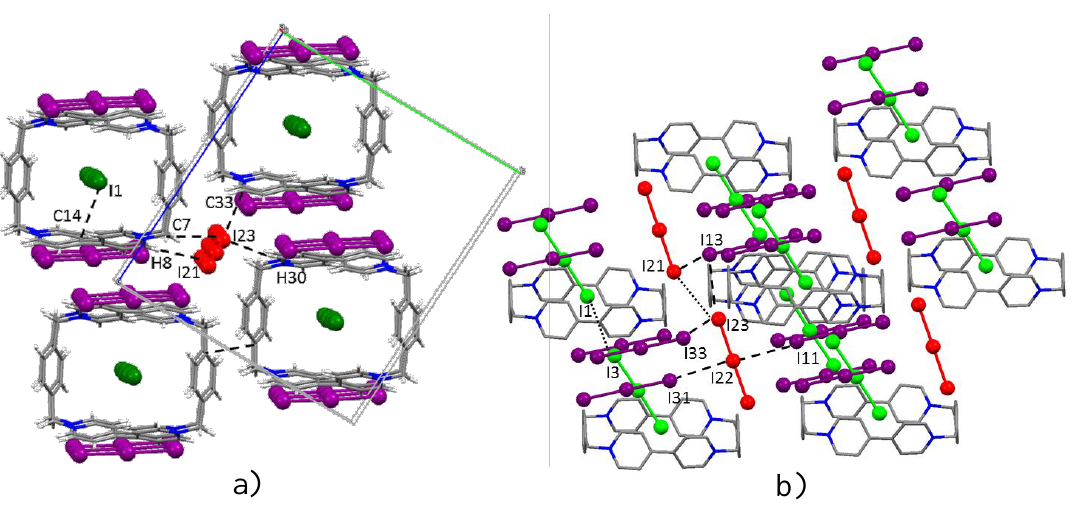
Figure 2. I 3 @BB(I 3 ) 3 · 2DMSO crystal structure. Top view ( a ) and lateral view ( b ) of the BB / I 3 − pillars growing along the a axis. Color code: purple: triiodides bridging piled BB; green: triiodides inside the BB cavity; red: triiodides outside the BB pillars. DMSO molecules omitted for clarity. I ... I, C ... I, and H ... I contacts as dashed lines.